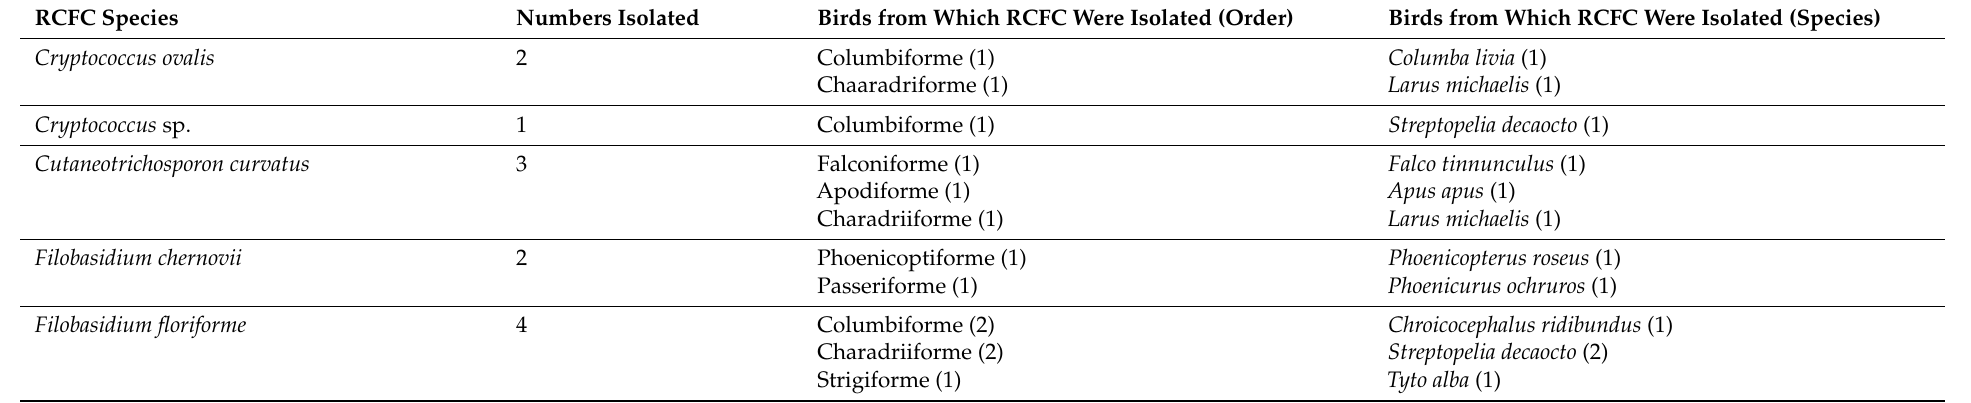
Table 2. Distribution of rare Cryptococcus and former Cryptococcus (RCFC) species by numbers found during the study and corresponding birds (Orders and species) they were isolated from. Numbers in brackets indicate the number of individual birds within an order or a specie the corresponding RCFC were isolated